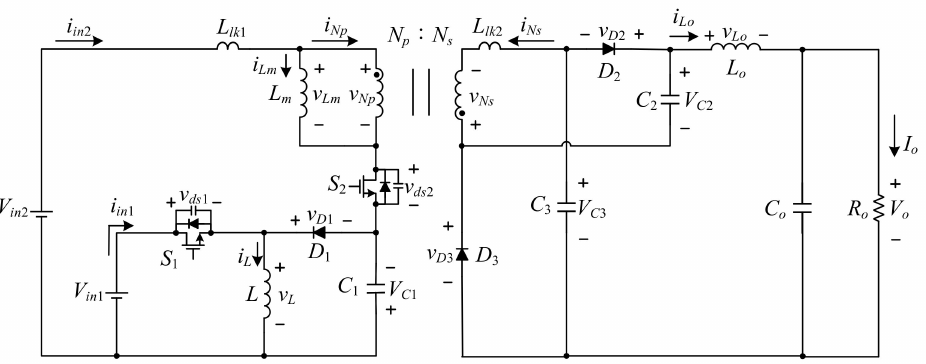
Figure 5. Proposed isolated MISOC